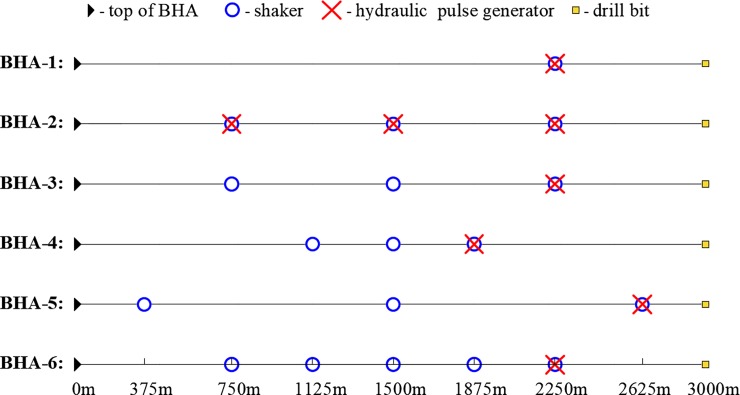
Bottom hole assemblies (BHAs) of different drilling manners.https://dx.doi.org/10.17504/protocols.io.ke3ctgn.